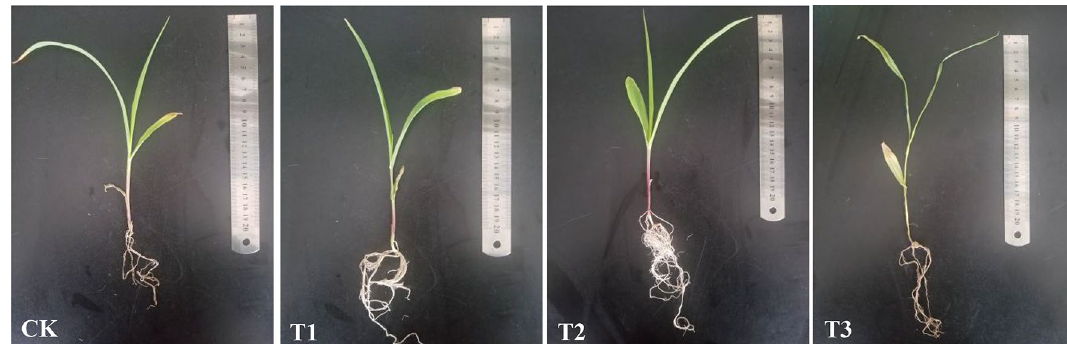
Figure 8. Effect of different treatments on disease resistance of maize at seedling